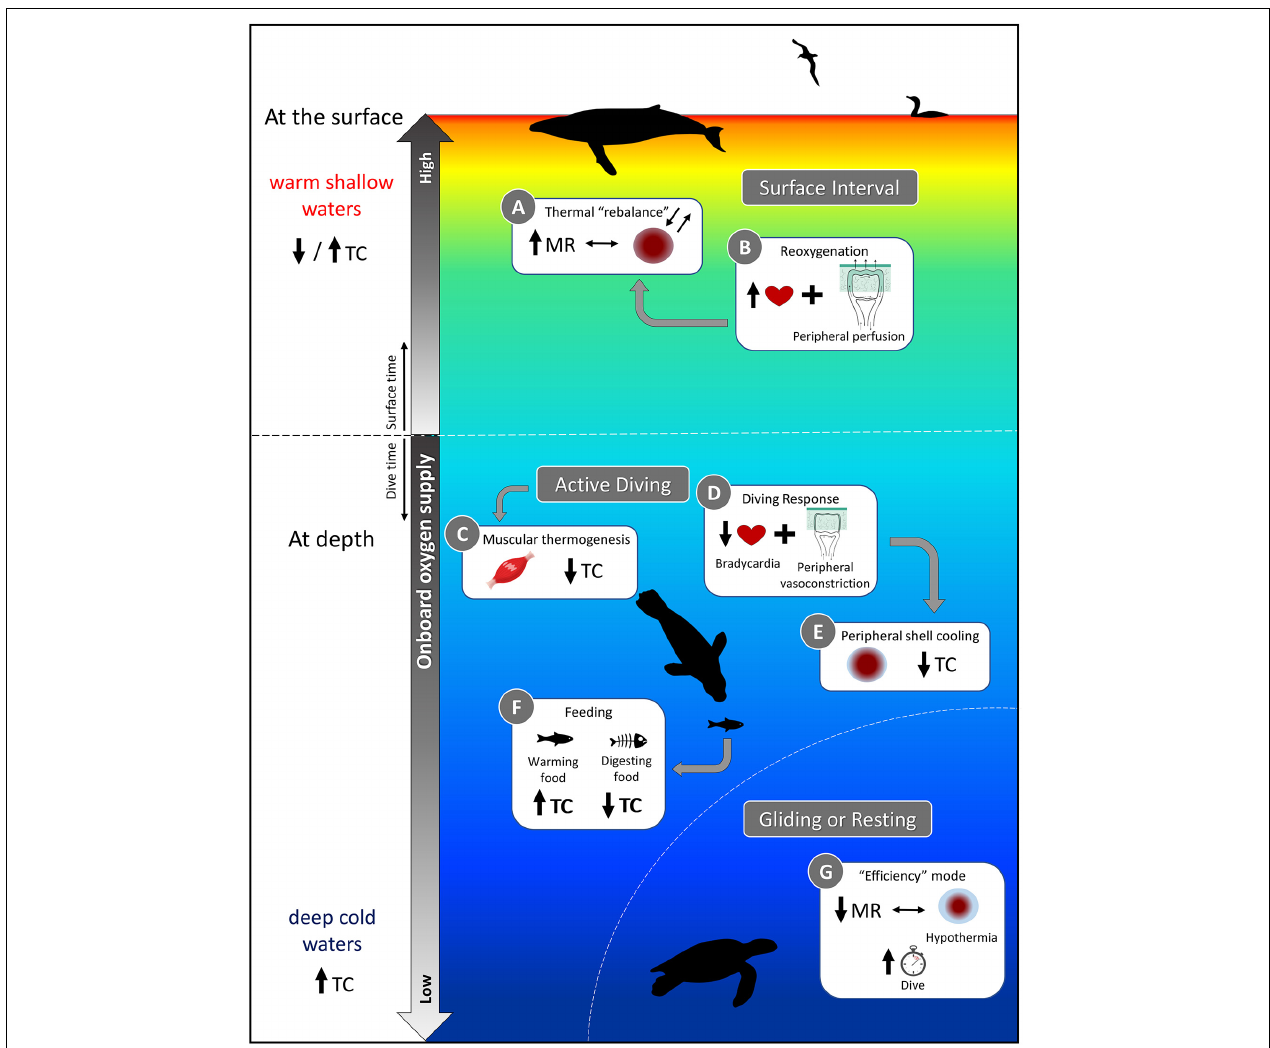
FIGURE 9 | A schematic representation of the various physiological demands faced by air-breathing divers and how thermoregulatory costs (TC) are affected. While some activities, such as digestion (Box F) and muscular heat production (Box C) may reduce TC through substitution, diving into cold waters will increase TC (bottom side panel), unless mechanisms to mitigate heat loss are used [Box E and G; e.g., long, resting dives of sea turtles in which metabolic rate (MR) is reduced]. A relaxation of the dive response at the surface (Box B vs. Box D at depth) may facilitate regaining thermal balance (Box A), but the relative amount of time spent at the surface to achieve homeostasis may also be dictated by gas exchange in addition to thermoregulatory functions. If TC increases because surface waters are too warm to dump sufficient heat to compensate for increased activity, thermal inertia, etc. (top side panel), then diving activity may be altered to account for increased thermoregulatory needs. Refer to sections “Consequences of the Dive Response on Thermoregulation,” “Exercise vs. Thermoregulation: Context-Dependent Interactions and Strategies,” and “Ingestion and digestion of cold prey: A sink and source of heat” of the text for further